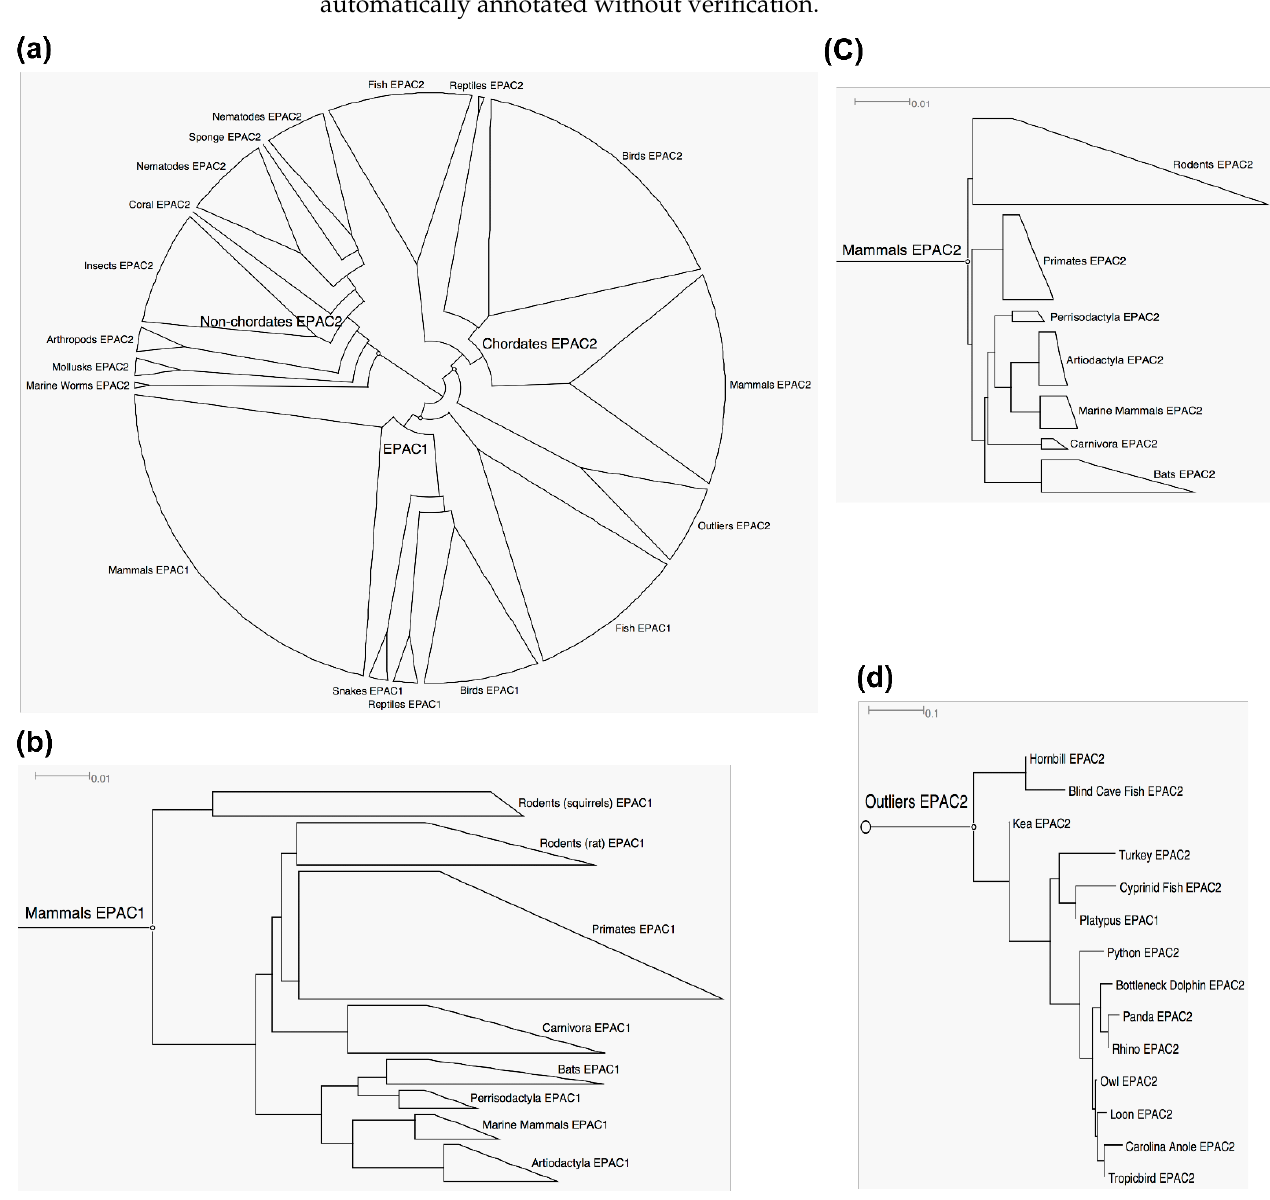
Figure 2. Phylogenetic analyses of EPAC1 and EPAC2. ( a ) Unrooted cladogram of EPAC1 and EPAC2. ( b ) Rooted phylogram of mammalian EPAC1. ( c ) Rooted phylogram of mammalian EPAC2. ( d ) Rooted phylogram of EPAC2 outliers. Scale bars: 0.01 or 0.1 represents 1 aa substitution per 100 or 10 aa, respectively.